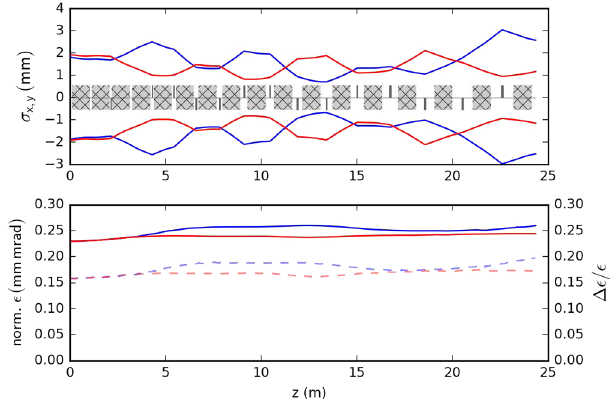
FIG. 11. rms beam envelope for the second pass using 6D Gaussian initial distribution with 40 mA bunch current.